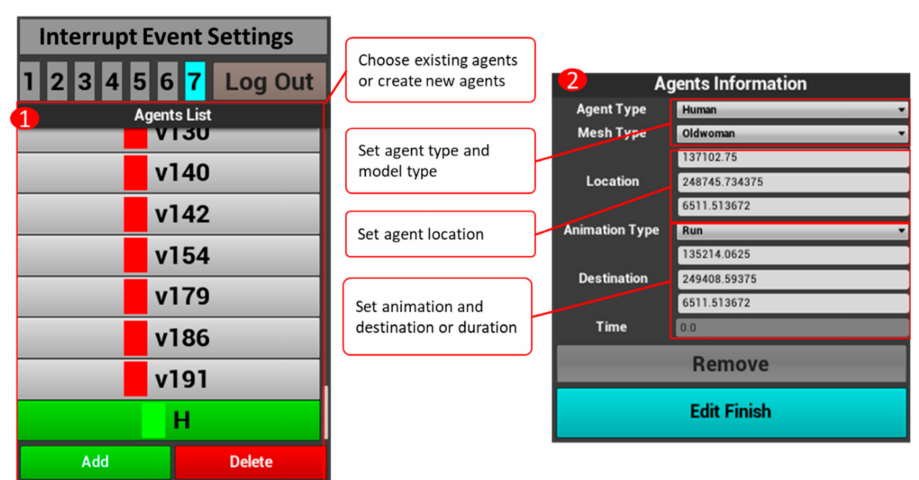
Figure 18. The detail editing UI of the interrupt event